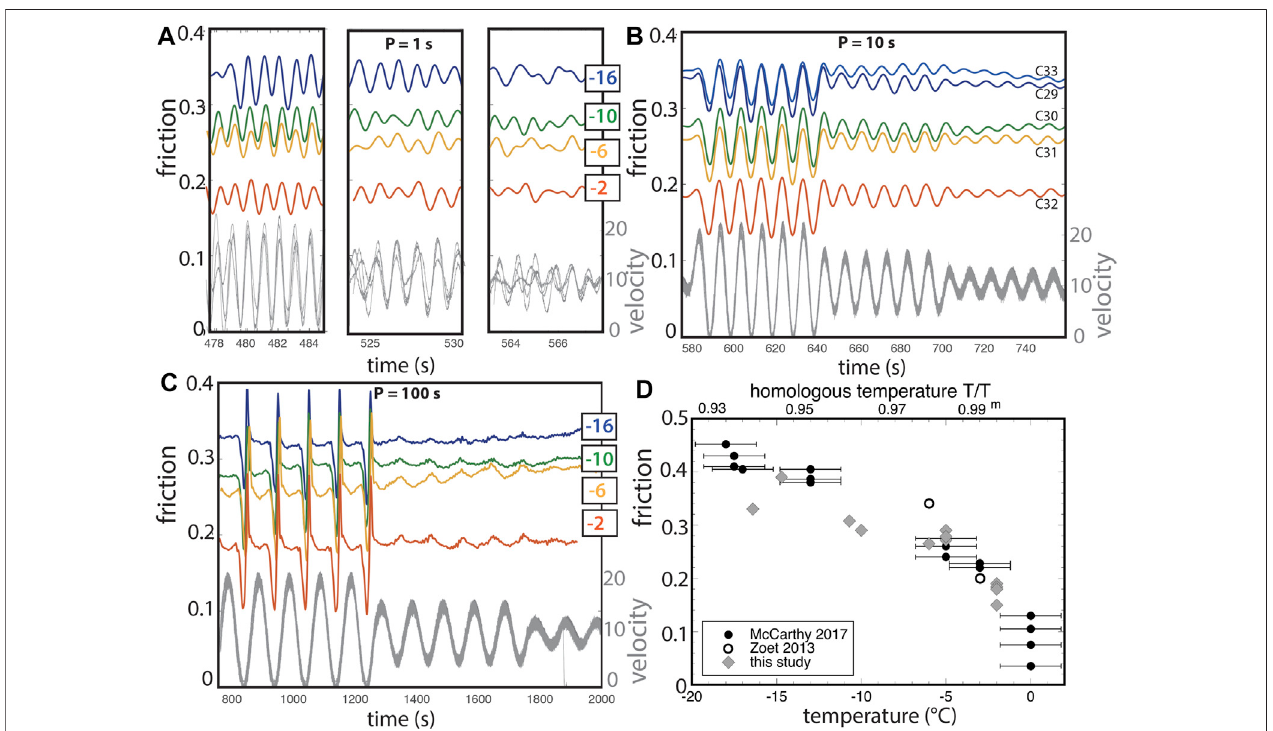
FIGURE 3 | Frictional response to periodic load point velocity (gray) as a function of temperature between − 16.4 ° C and − 2 ° C, from samples C29 − C33 at, respectively, at (A) 1 s periods; (B) 10 s periods; and (C) 100 s periods. (D) Temperature directly affects the average friction, consistent with steady-state friction coef fi cients from previous studies (Zoet et al.,2013; McCarthy et al., 2017).